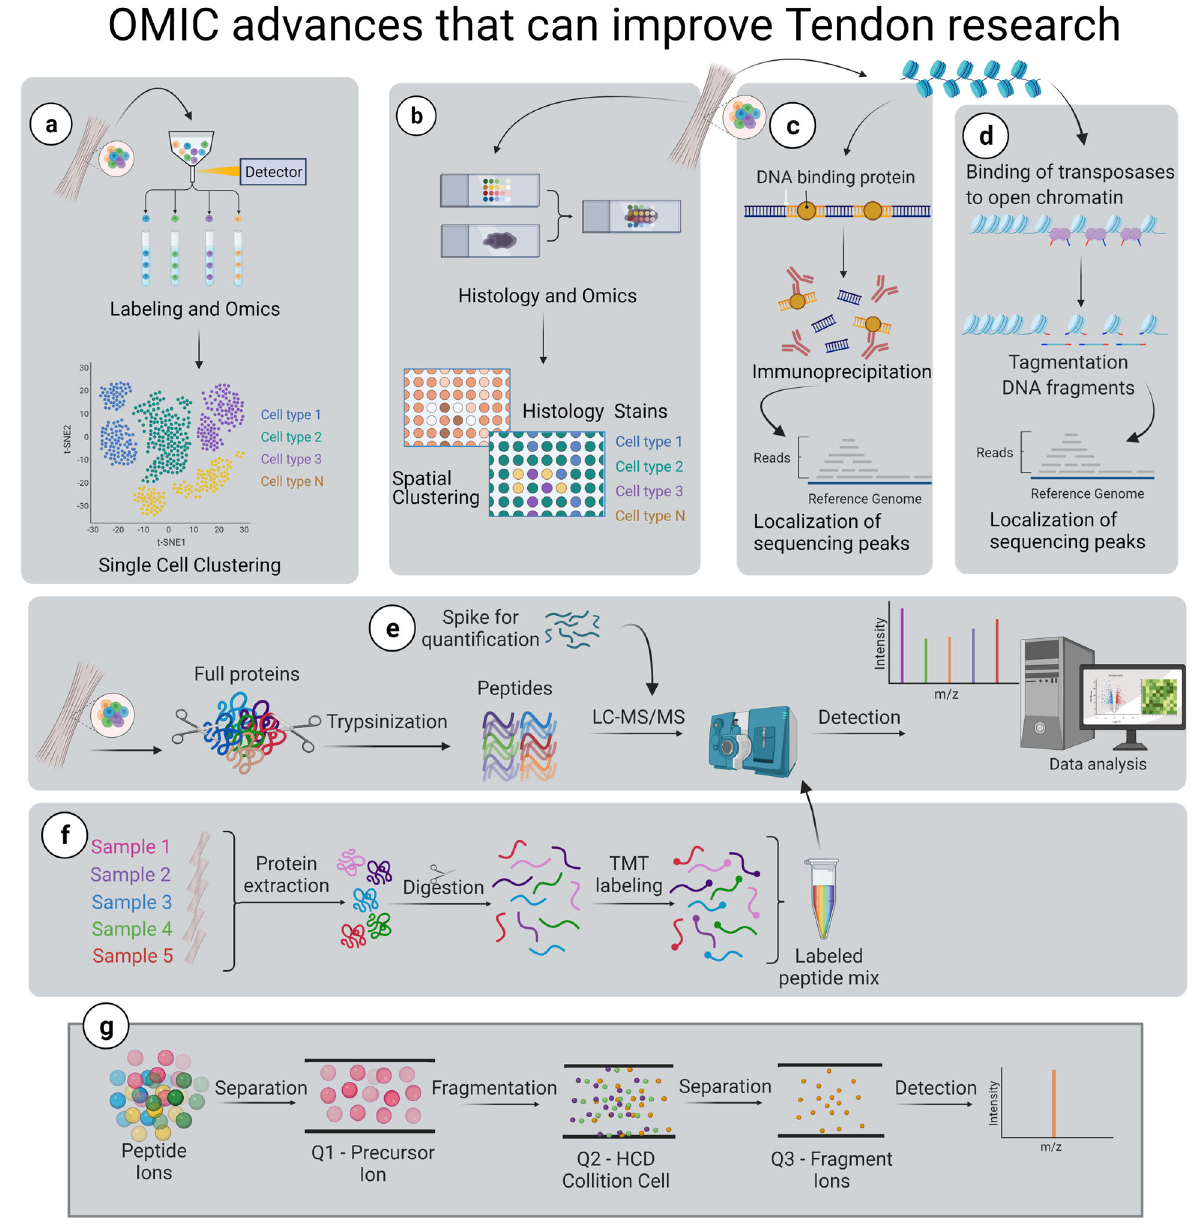
Fig. 5 ‘ Omic advances that can improve capabilities of tendon research. a Single-cell ‘ omics allows for evaluation of differential expression of genes by cell, or sub-cellular component, and then identify clusters. b Spatial clustering ‘ omics allows for the evaluation of samples in slides that allow for histology staining and identi fi cation of genetic material by location, in order to obtain an image of differential gene expression. c Immunoprecipitation sequencing allows the identi fi cation of regions through the chromatin that currently attach any protein (i.e., histones, transcription factors) and permits the understanding of transcriptomic changes through metagenomics. d Assay for transposase-accessible chromatin sequencing allows to identify the accessible areas of the DNA that allow different phenotype differentiation. e Proteomics allows for absolute quanti fi cation by spiking samples with known or labeled peptides. f Similarly, Tandem Mass Tag labeling allows for the evaluation of multiple samples simultaneously. g The proteomic analysis allows for a selection of peptides and fragments that can be quanti fi ed in order to de fi ne a speci fi c phenotype. Created in